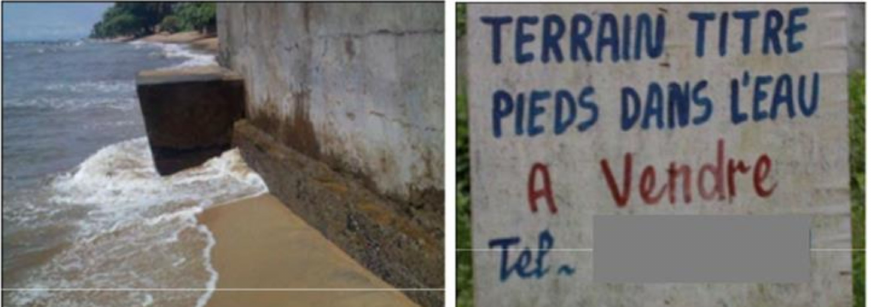
Figure 24. Land pressure on the coast in Kribi. The photo on the left shows the foundation of a private hotel in Kribi, directly built on the coastline (titled land—feet in the water—for sale). The photo on the right was taken − 10 m from the shoreline. Indeed, since the entry into office of the PAK, there has been a major land race in this city, which has become the new growth pole of Cameroon. Land sales are multiplying, even in the private domain of the state, and advertisements are multiplying on the internet. The 2008 state law prohibiting the occupation of land 50 m from the coastline has thus been